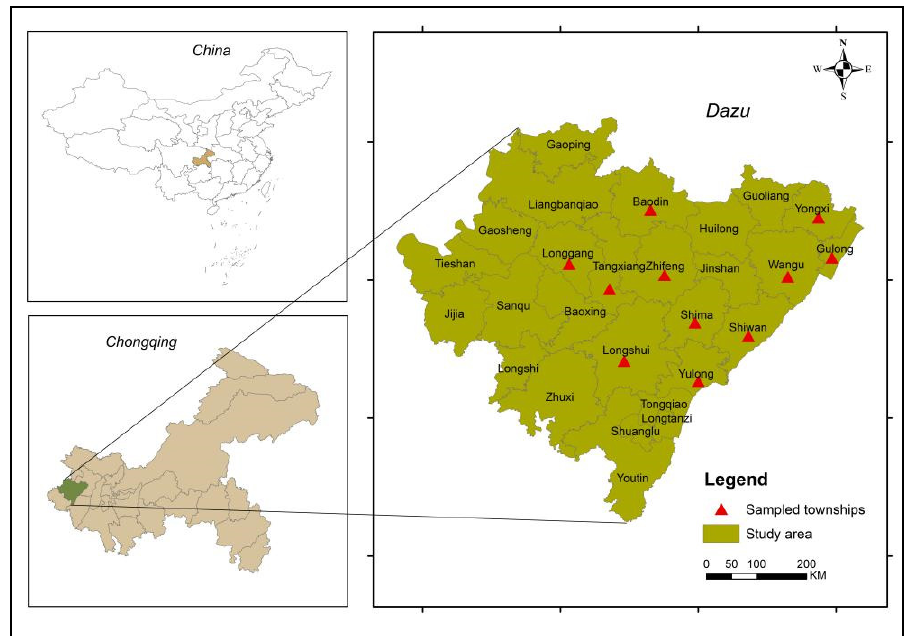
Figure 3. Geographical location of the study area.